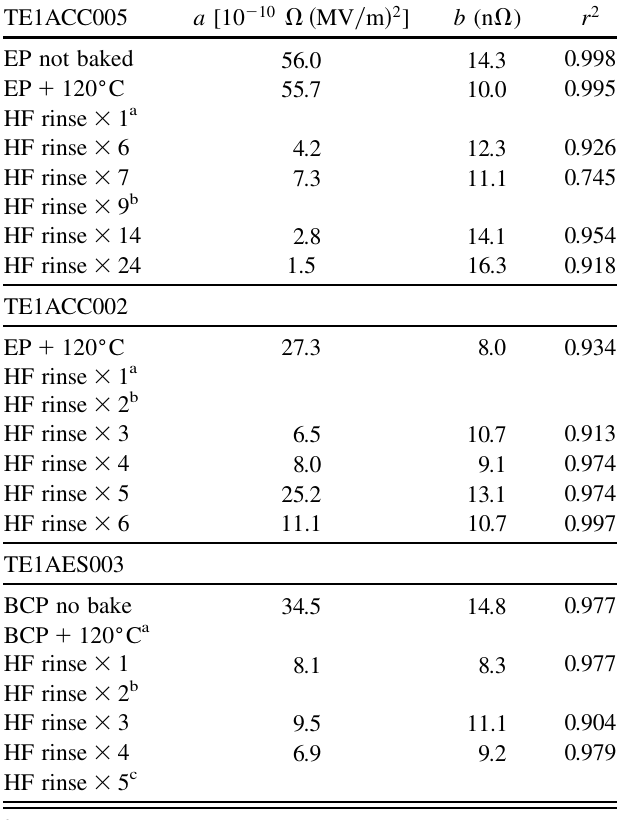
TABLE III. Parameters for the fits based on Eq. (1) of the low field Q slope in the bulk electropolished (EP) cavity (TE1ACC005), bulk EP þ tumbling þ light EP cavity